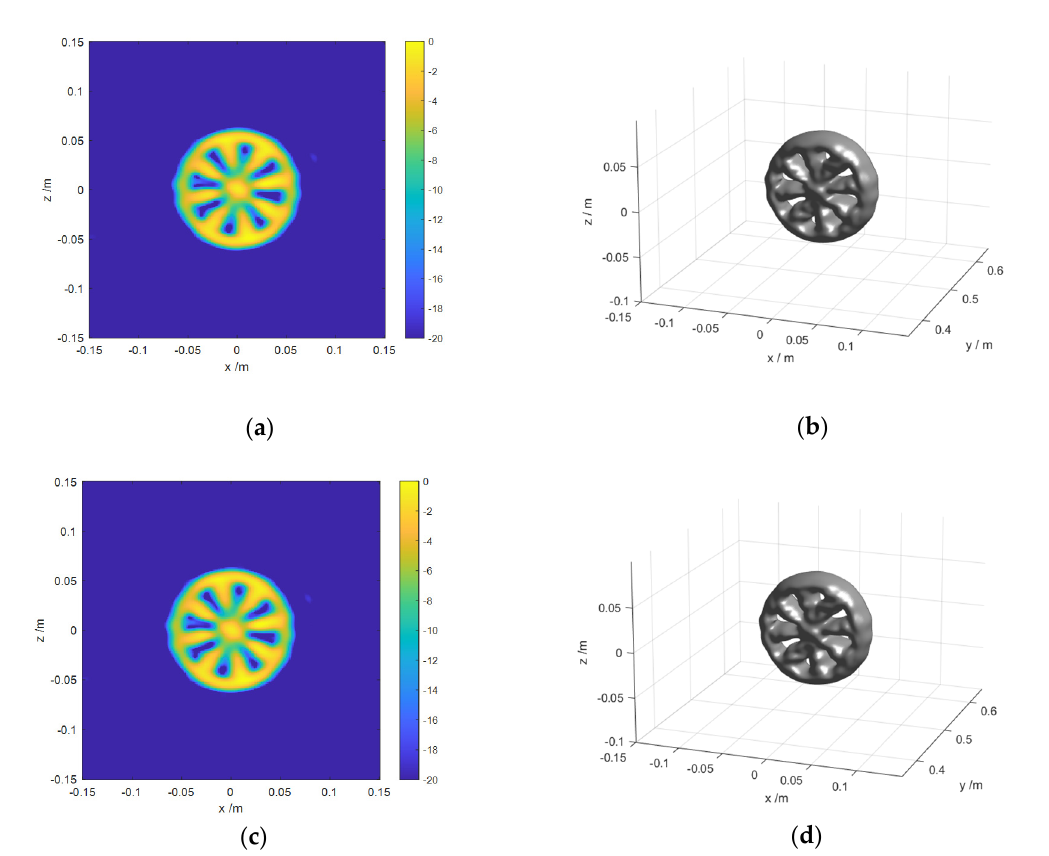
Figure 11. Imaging results of different algorithms for ARRAY B: ( a ) and ( b ) are the imaging result of the proposed algorithm; ( c ) and ( d ) are the imaging result of BP algorithm.